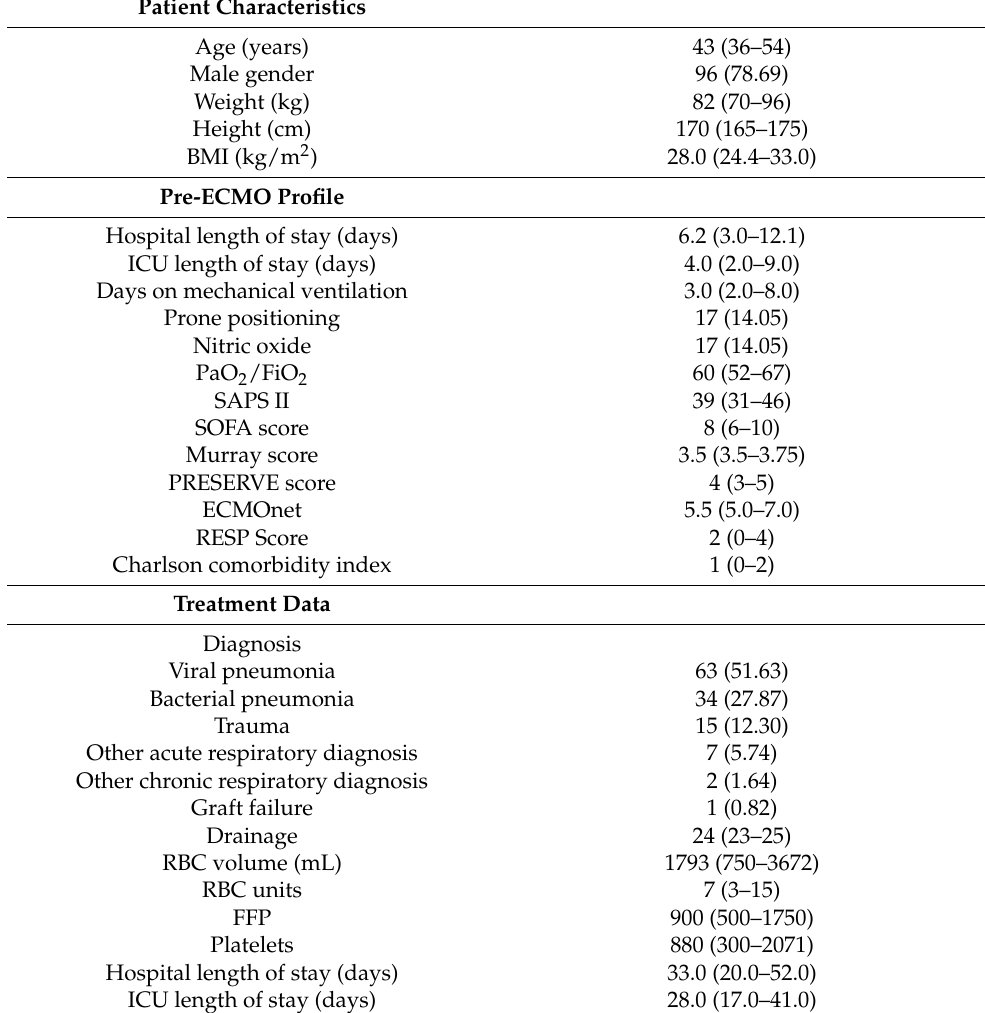
Table 1. Baseline characteristics, pre-ECMO profile, diagnosis, and treatment